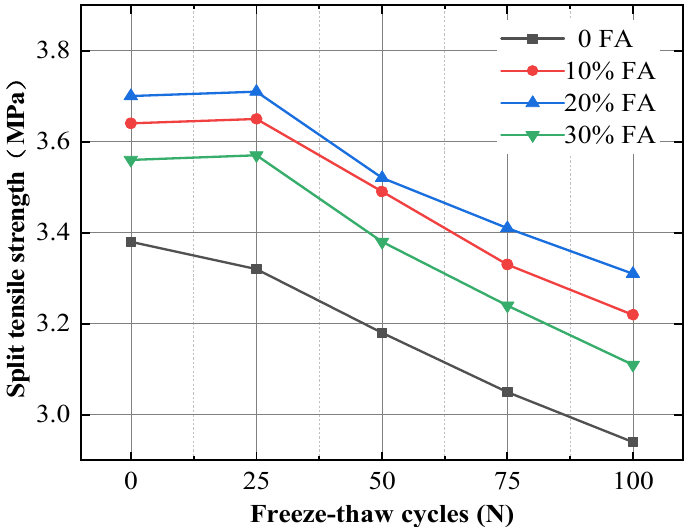
Figure 6. Splitting tensile strength of concrete.